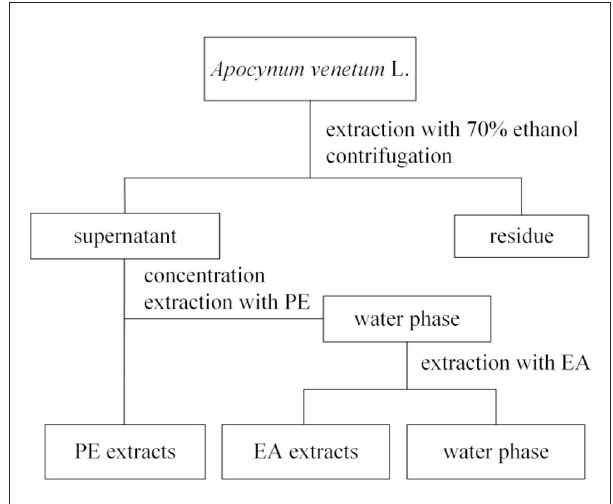
FIGURE1 A procedure for ethanol extraction and separation of the petroleum ether (PE), ethyl acetate (EA), and water